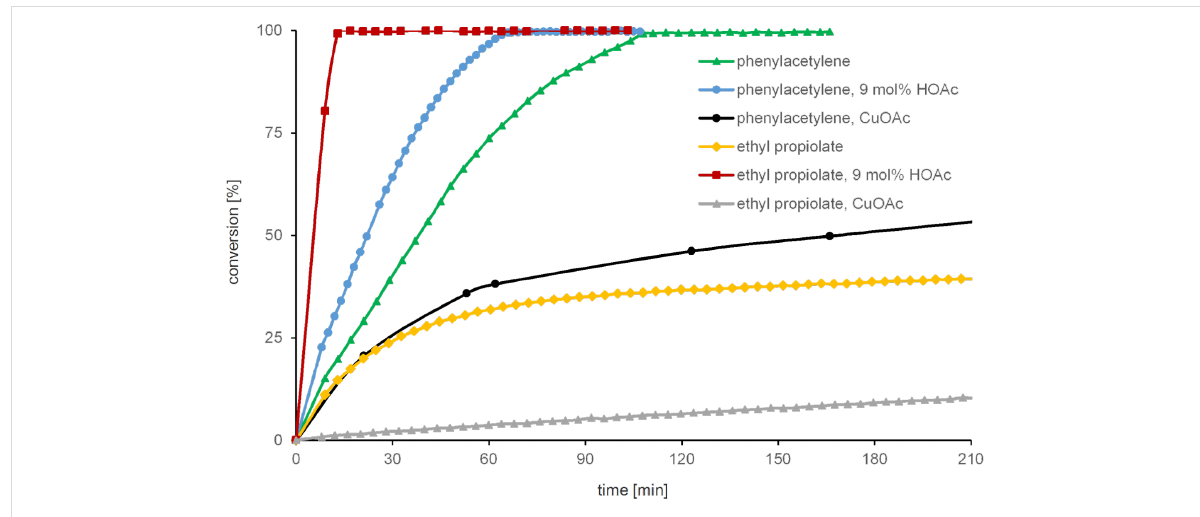
Figure 2: Time-conversion-diagram of the CuAAC reaction of benzyl azide with either phenylacetylene or ethyl propiolate in the presence of copper complex 2 (1.8 mol % for reaction with phenylacetylene, 0.9 mol % for reaction with ethyl propiolate) or in presence of CuOAc (saturated homoge- neous solution) under an atmosphere of nitrogen in CD 2 Cl 2 at rt (conversion referred to benzyl azide); reaction with phenylacetylene: green triangles (complex 2 without additional HOAc), blue dots (complex 2 in presence of 9 mol % additional HOAc) and black dots (CuOAc solution); reaction with ethyl propiolate: yellow diamonds (complex 2 without additional HOAc), red squares (complex 2 in presence of 9 mol % additional HOAc) and grey tri- angles (CuOAc